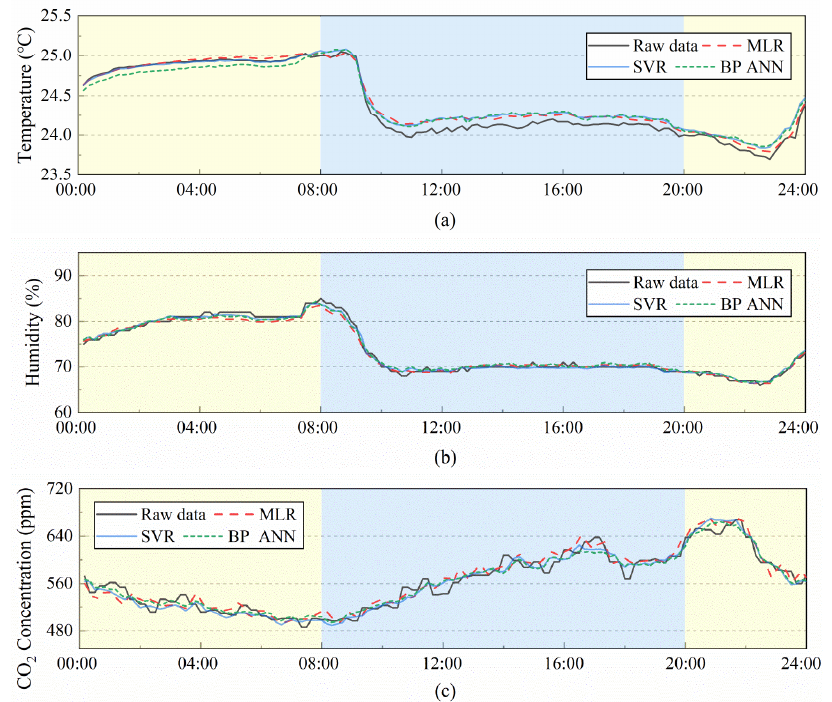
Figure 8. Distribution of training validation and test data.